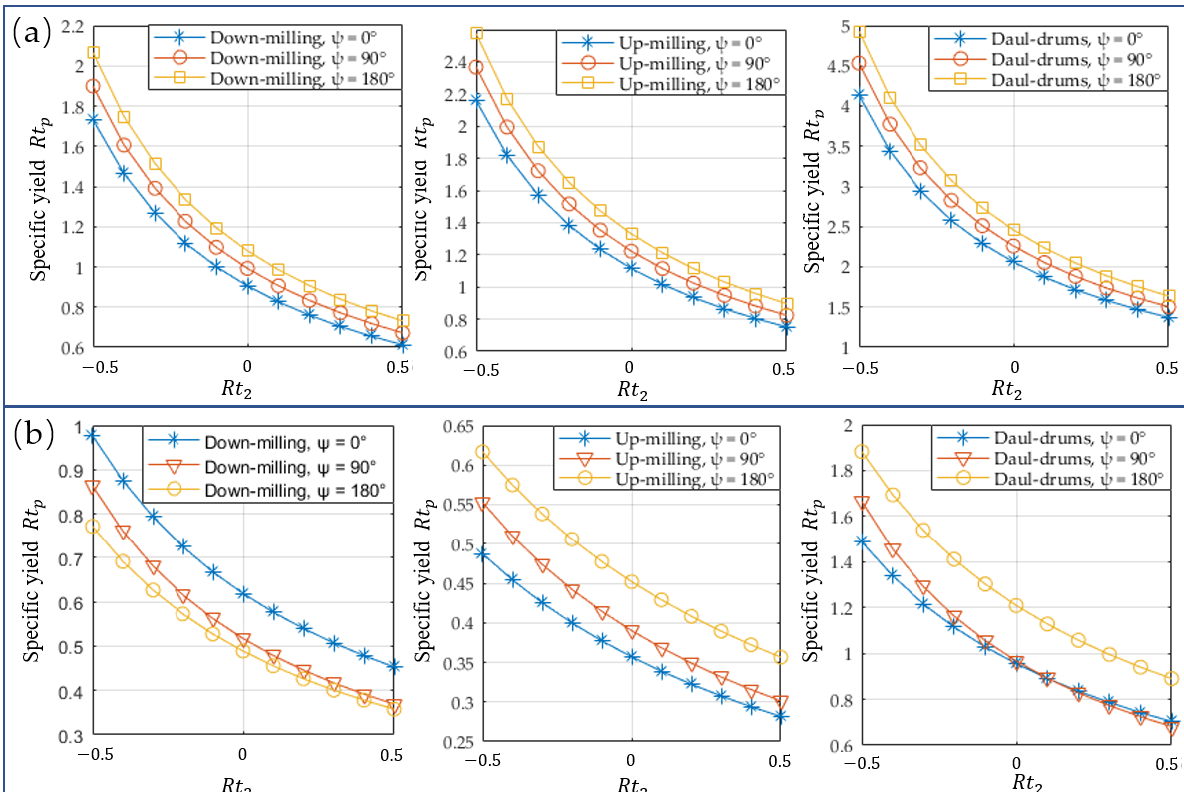
Figure 9. Influence of cutting head position on stability of mining vehicle. ( a ) Slope stability condition; ( b ) anti-skid steering stability condition.